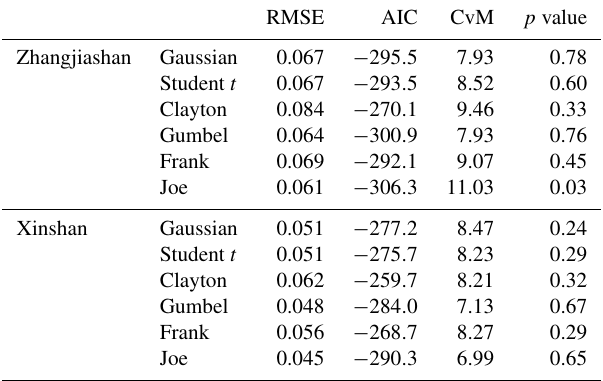
Table 3. Performance for quantifying the joint distributions be- tween flood peak and volume through different copulas: CvM is the Cramér–von Mises statistic proposed by Genest et al. (2009), with a p value larger than 0.05 indicating satisfactory performance. RMSE AIC CvM p